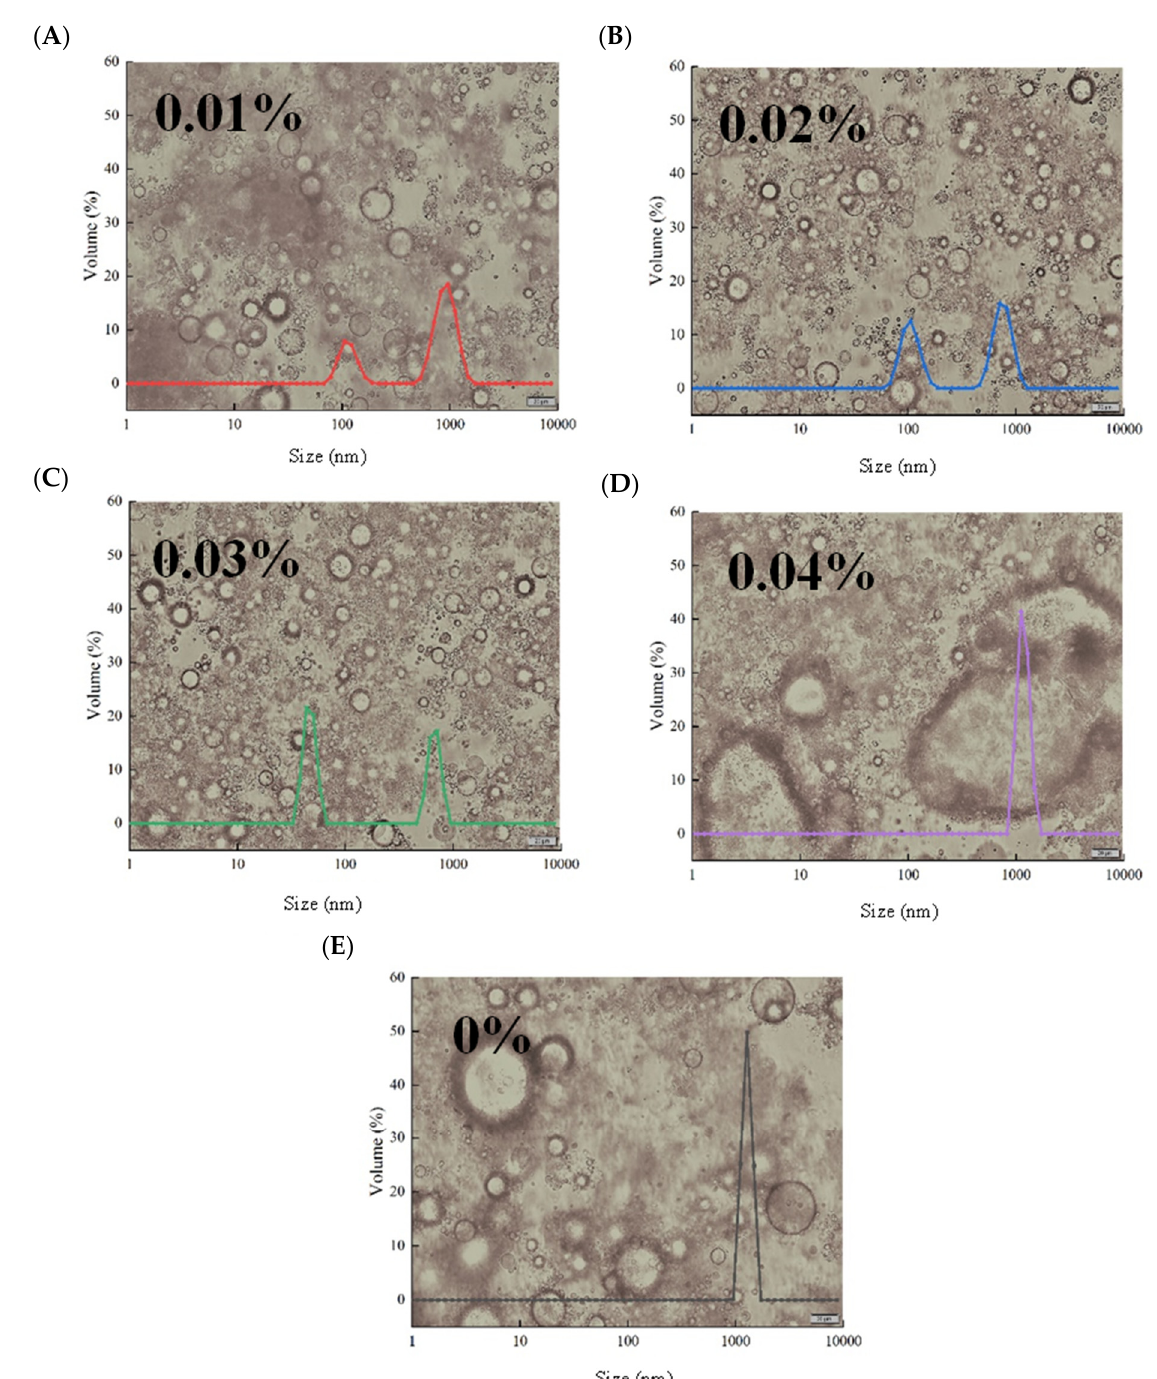
Figure 2. Changes in droplet size distribution and optical micrograph of wooden breast myofibrillar protein emulsion with different (-)-epigallocatechin-3-gallate addition ( A – E ). Note: intermediate peak A (around 100 nm), intermediate peak B (around 1000 nm).